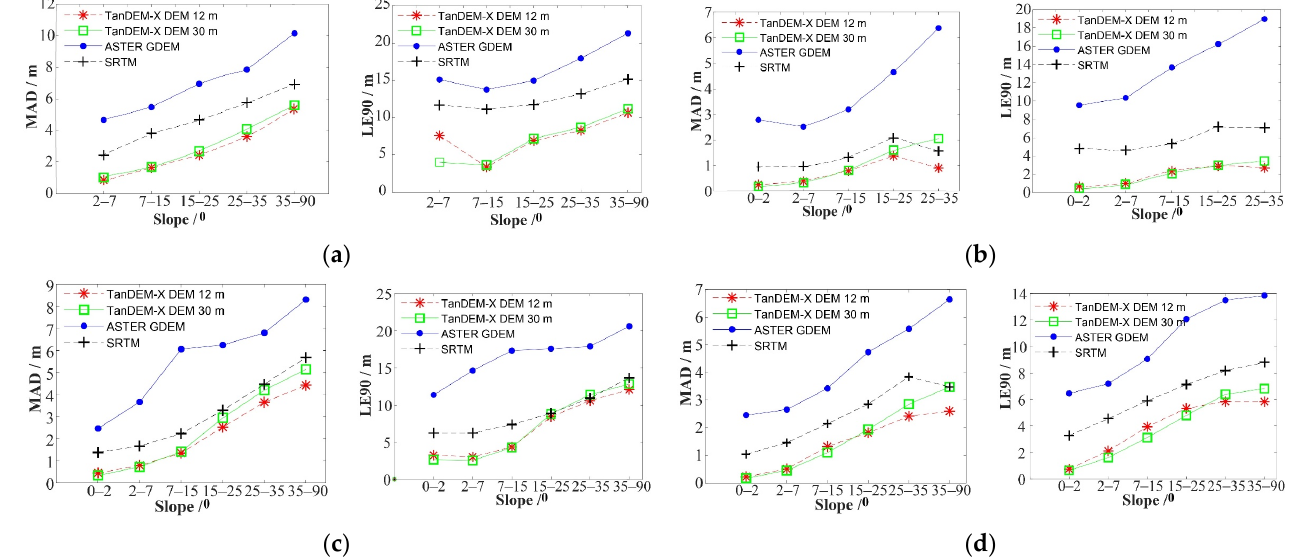
Figure 7. The relationship between quality indicators ((left) MAD and (right) LE90) and slopes in four study areas: ( a ) Sichuan; ( b ) Xinjiang A; ( c ) Xinjiang B; and ( d ) Inner Mongolia.